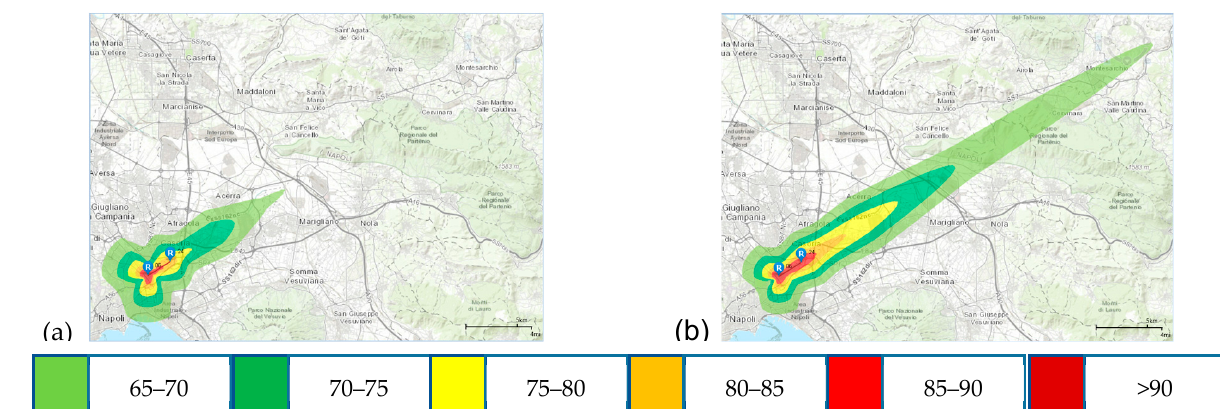
Figure 40. Graphical representation of equal loudness contours for the conventional ( a ) and hybrid ( b ) configurations, in terms of L AE (dB-A), for a standard runway-06 take-off.